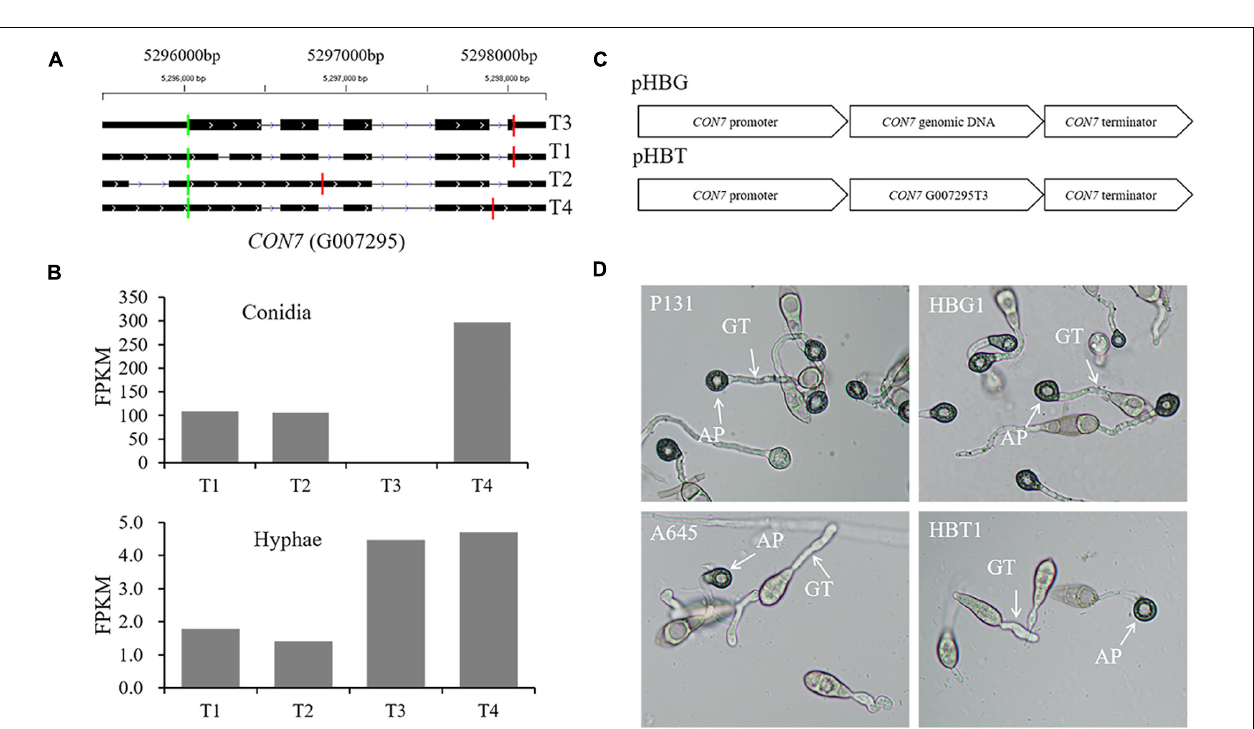
FIGURE 8 | Fold changes in expression levels of splicing factor genes and NMD pathway genes between the conidia and the hyphae.